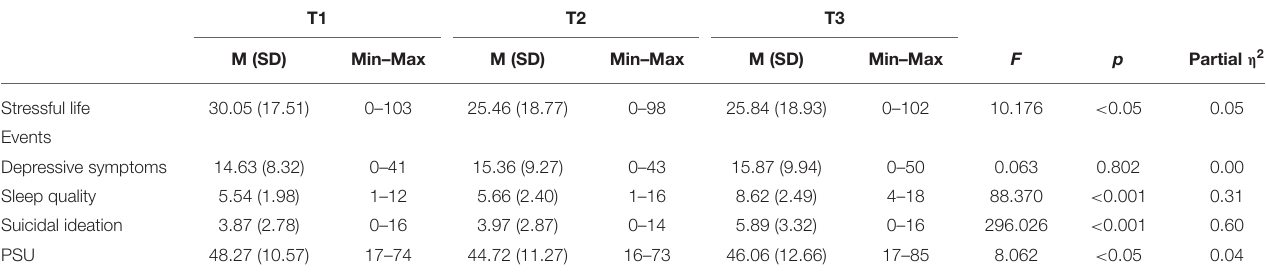
TABLE 1 | Mean, SD, minimum, maximum, and repeated-measures ANOVAs (T1, T2, and T3) of all variables. T1 T2 T3 M (SD) Min–Max M (SD) Min–Max M (SD) p